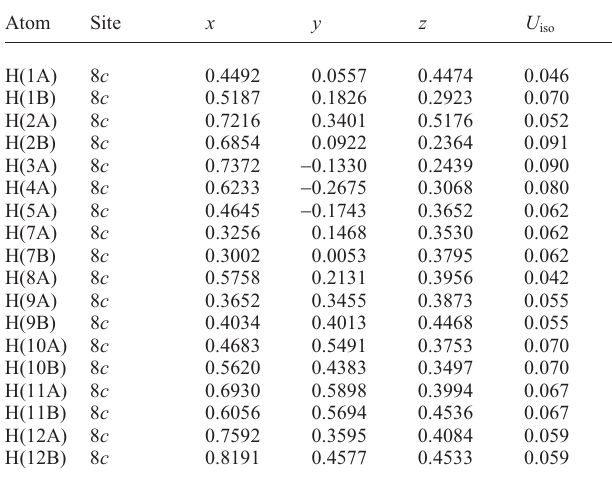
Table 2. Atomic coordinates and displacement parameters (in Å 2 ) . Atom